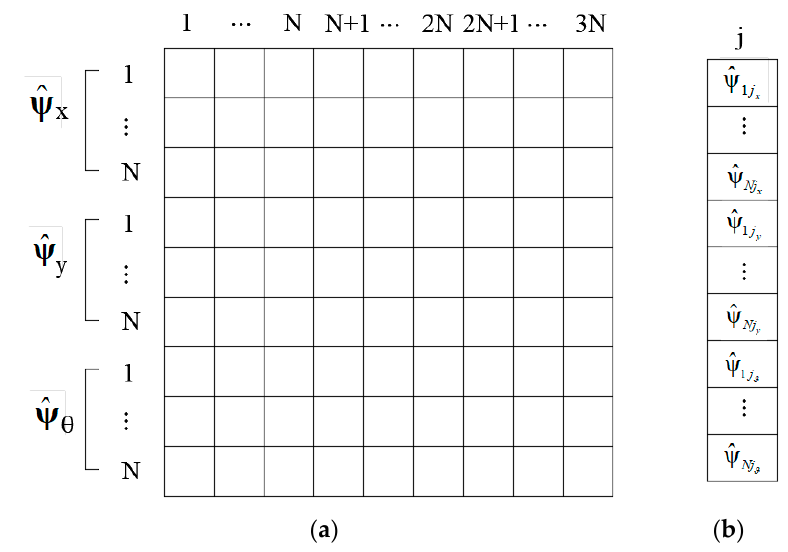
Figure 3. Scheme of ( a ) the eigen-vector matrix and ( b ) the j-th eigen-vector.